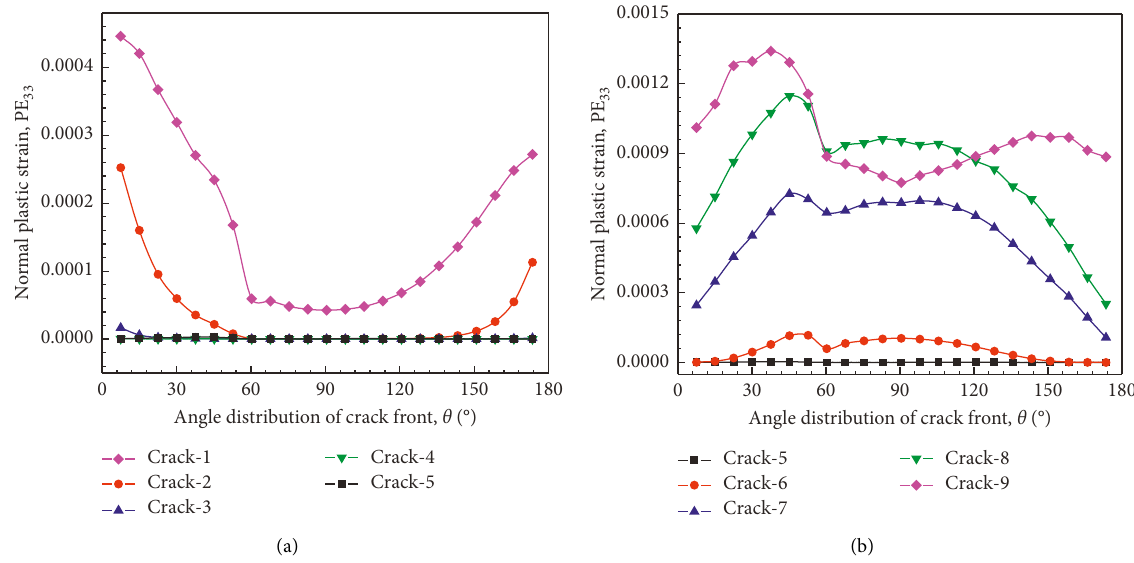
Figure 13: Distribution of normal plastic strain along crack front with crack angle. (a) Cracks-1 ∼ 5. (b) Cracks-5 ∼ 9.